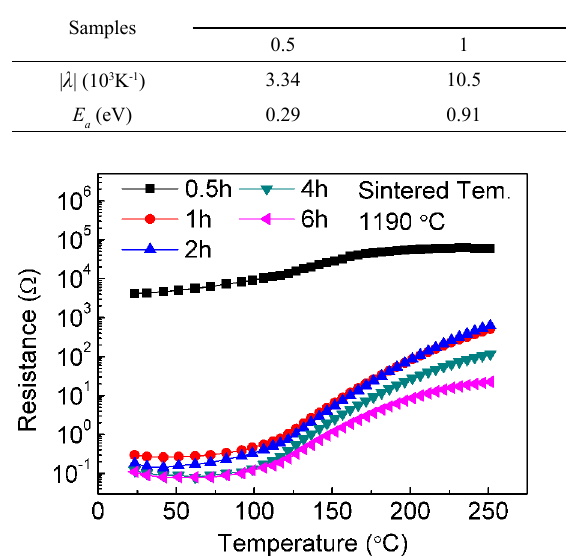
Figure 4. The temperature dependence of resistance for different sintering time.